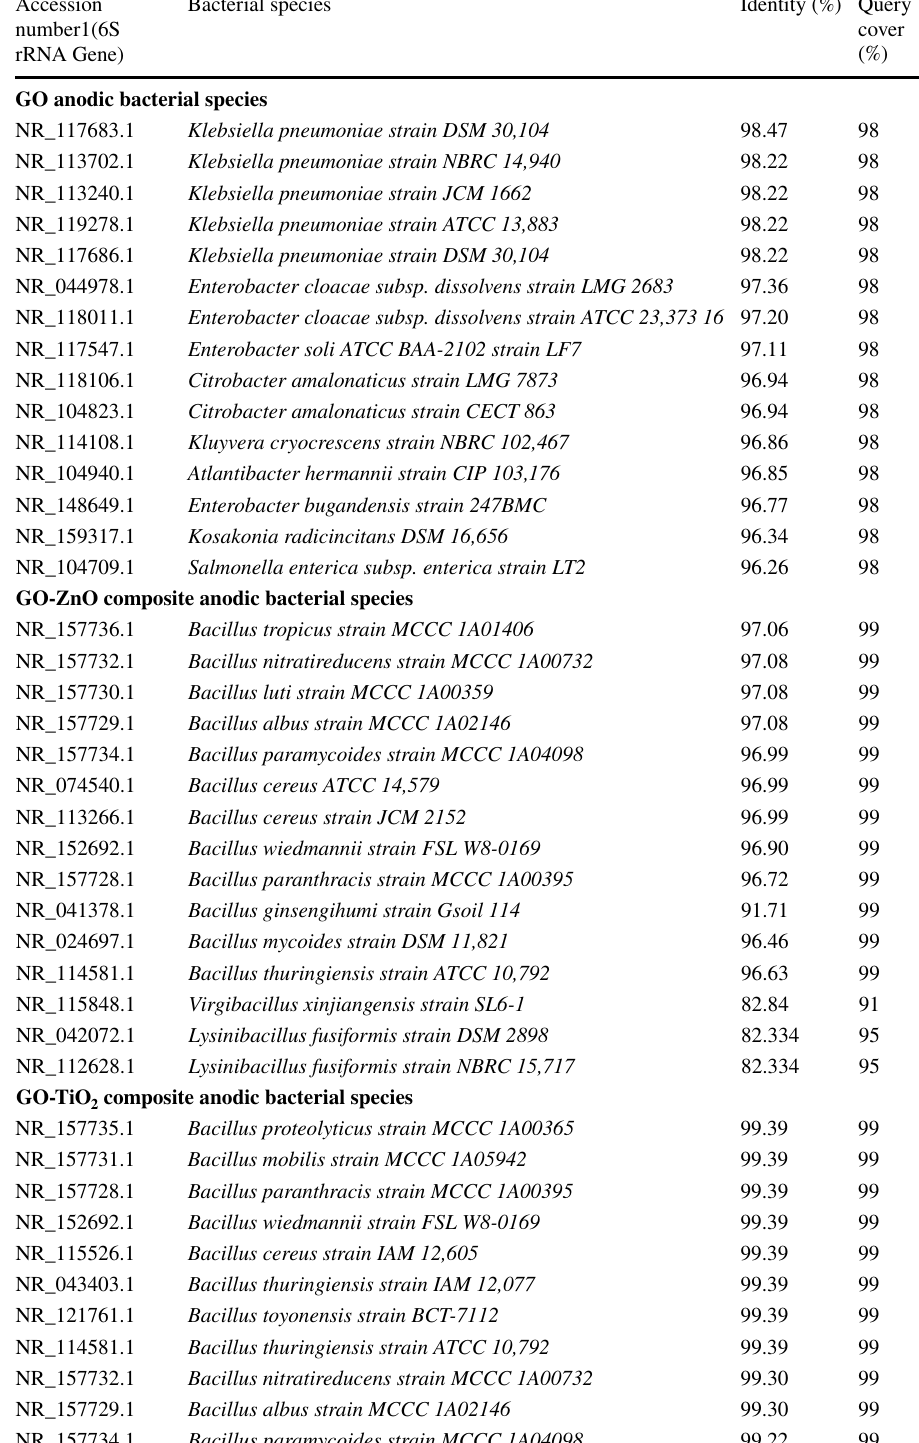
Table 5 Summery of identified bacterial species from anode